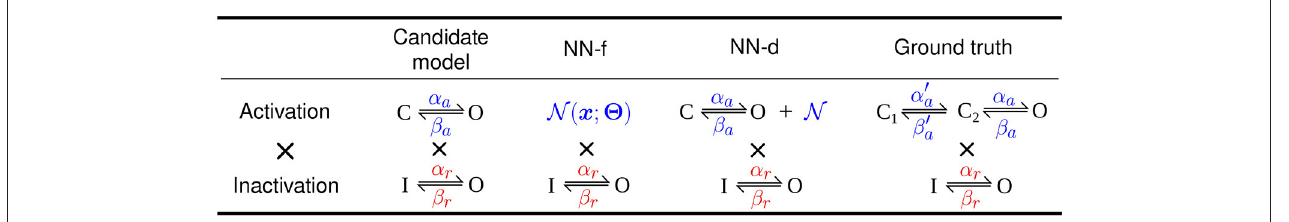
FIGURE 1 | Models of hERG used in synthetic data studies. studies. From left to right shows the original Hodgkin-Huxley model (candidate model), the activation modelled using a neural network (NN-f), the activation with a neural network discrepancy term (NN-d), and the activation modelled with a three-state model (ground truth). All models have the same (independent) inactivation.